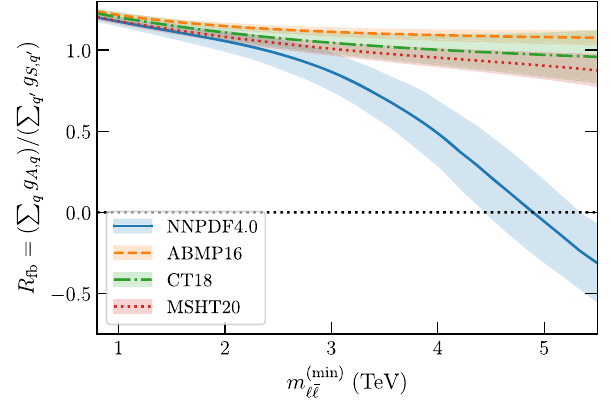
Fig. 15 The coupling ratio R fb , Eq. (3.7), that enters the forward– backward asymmetry A fb ( cos θ ∗ ) at LO, Eq. (2.23), for different PDF sets, as a function of the lower cut in the dilepton invariant mass m min